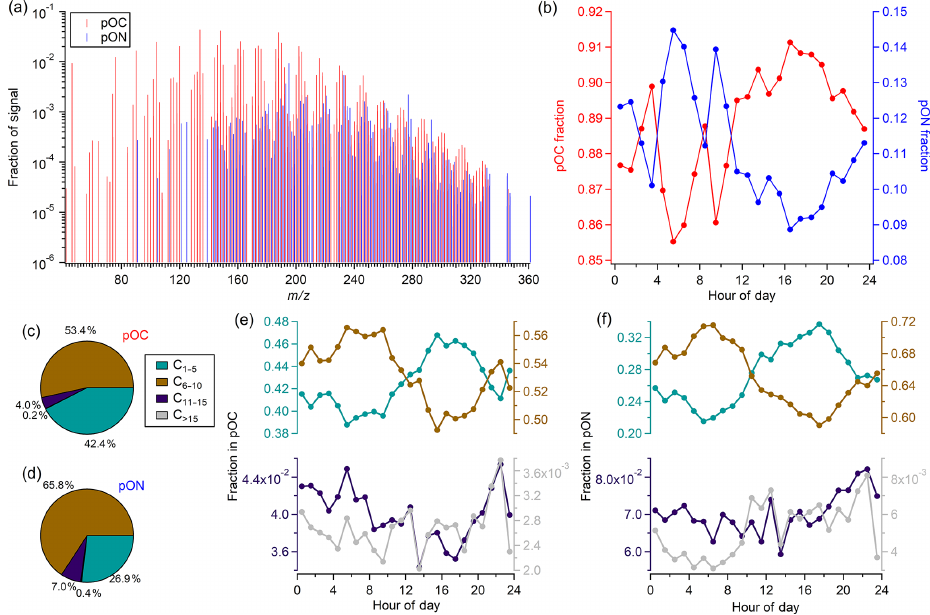
Figure 2. Study mean (a) FIGAERO mass spectra (C x H y O z ions in red and C z H y O z N 1 ions in blue), (b) fraction of pOC and pON compounds plotted as a function of time of a day, (c, d) fraction of ions of different carbon numbers (grouped as C 1–5 , C 6–10 , C 11–15 , and C > 15 ) in pOC and pON, and (e, f) fraction of C 1–5 , C 6–10 , C 11–15 , and C > 15 compounds in pOC and pON plotted as a function of time of